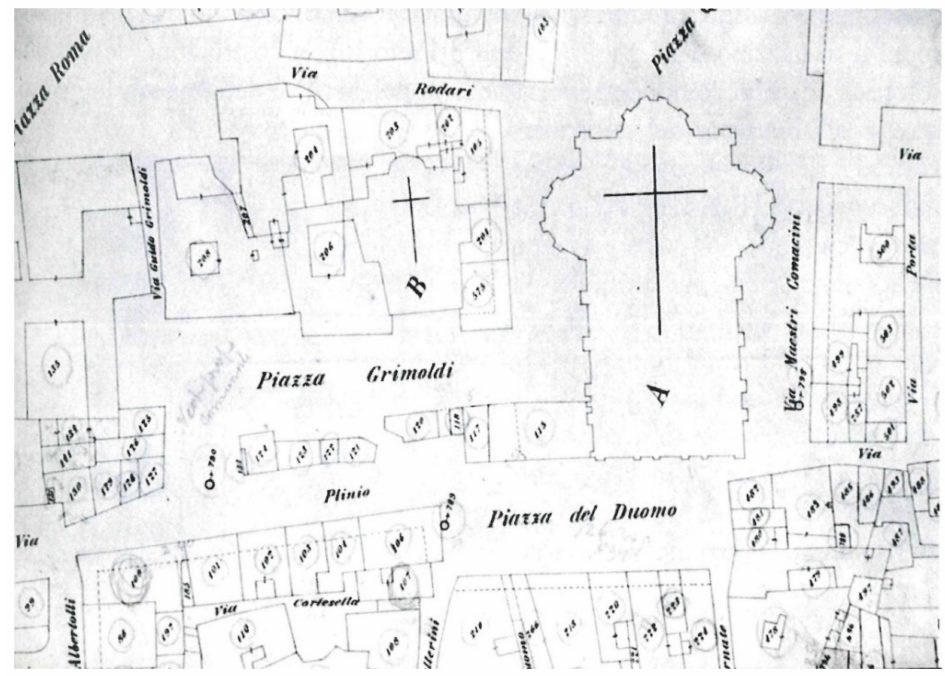
Figure 1. Cadastral update of 1888 with the monumental area of Broletto, Duomo, San Giacomo. A: Santa Maria Assunta Cathedral, B: San Giacomo